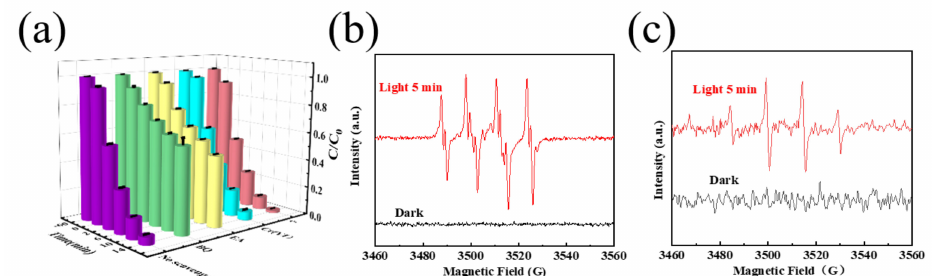
Figure 6. ( a ) Effects of different scavengers on photocatalytic degradation of MBT over CN-AA-0.05. ( b ) EPR spectra of CN-AA-0.05 in DMSO with DMPO as the capture agent. ( c ) EPR spectra of CN-AA-0.05 in deionized water with DMPO as the capture